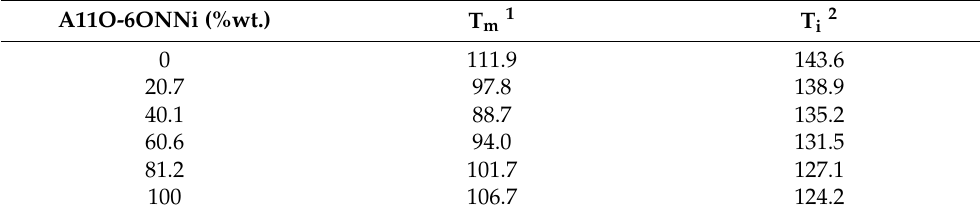
Table 3. Transition temperatures of A11O-6ONNi/A11O-6ONPd binary blends. A11O-6ONNi (%wt.)